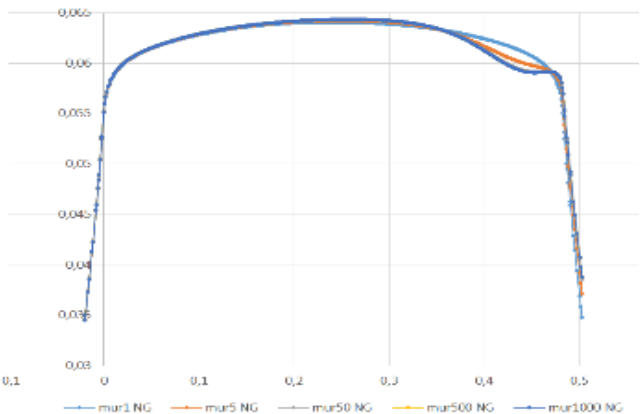
Fig. 8. Numerical measurments on a ficitve line of sensors disposed on the side of the furnace (along a vertical axis) The